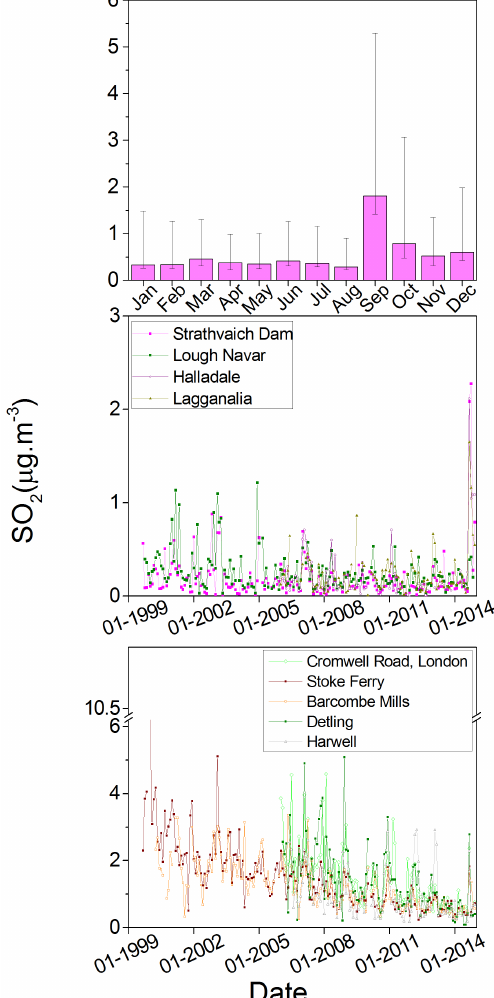
Figure 8. UK Defra Acid Gas and Aerosol Network monthly SO 2 . Top panel: 2014 monthly network average SO 2 concentration (30 sites, whiskers maximum and minimum values); middle panel: five remote sites in the network; bottom panel: five sites in southern Eng- land (Refer to Fig. 1 map for location of sites).